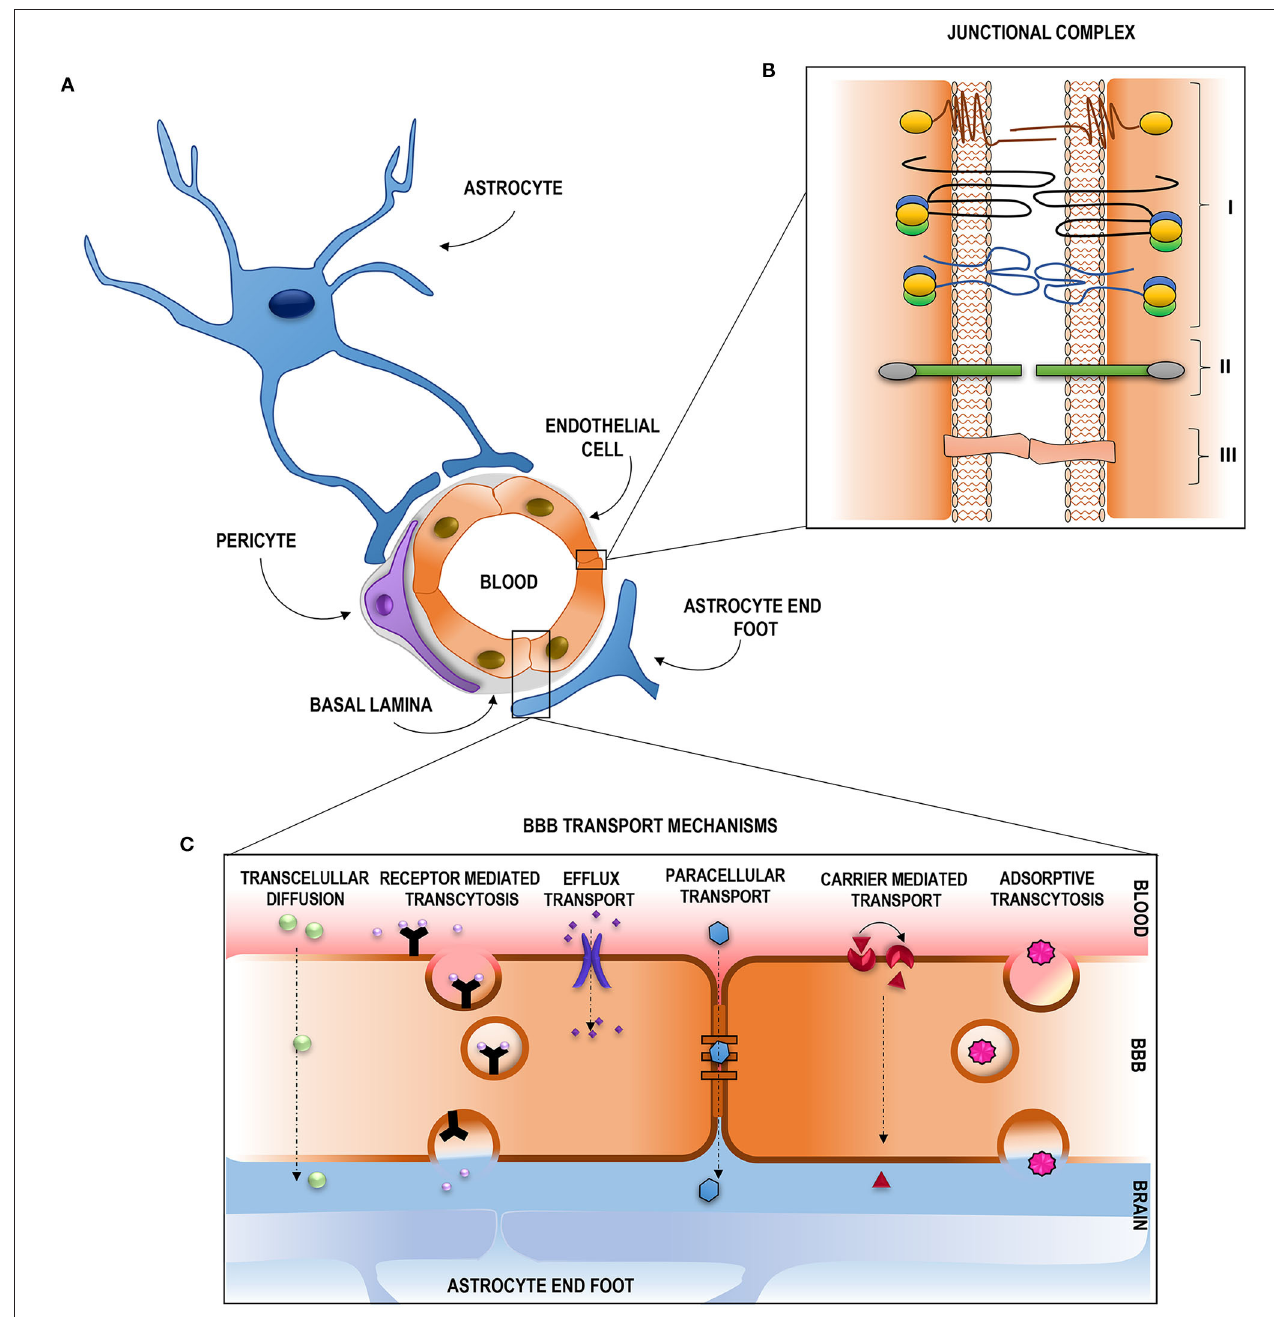
FIGURE 1 | Structural composition and transport pathways across the blood–brain barrier. (A) Representation of the distribution of the NVU components. (B) Junctional complex of the brain endotelial cells: (I) Tight junctions: composed by JAMS, caludins and occludins. ZO proteins are represented in yellow (ZO-1), green (ZO-2) and blue (ZO-3); (II) Adherens Junction, cadhenins represented in green and caterins in gray; (III) GAP junctions. (C) Schematic representation of the transport pathways across the BBB.